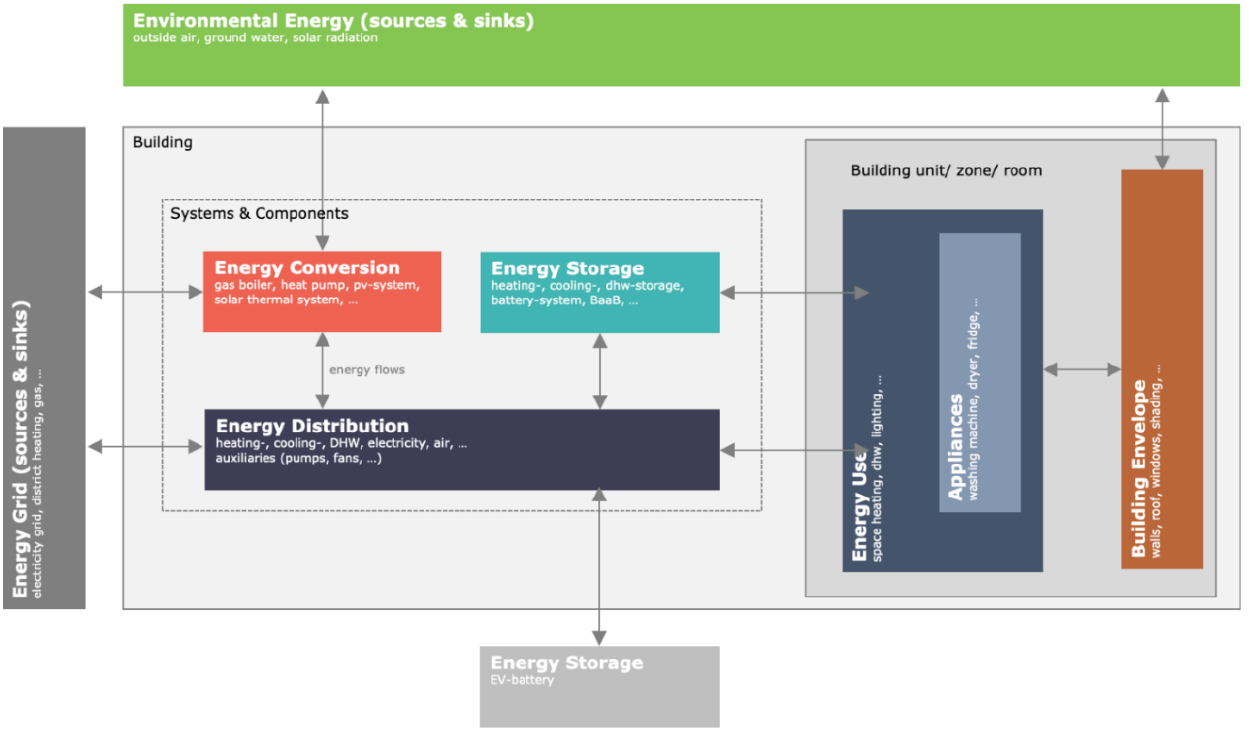
Figure 7. The EST groups as defined in [77].